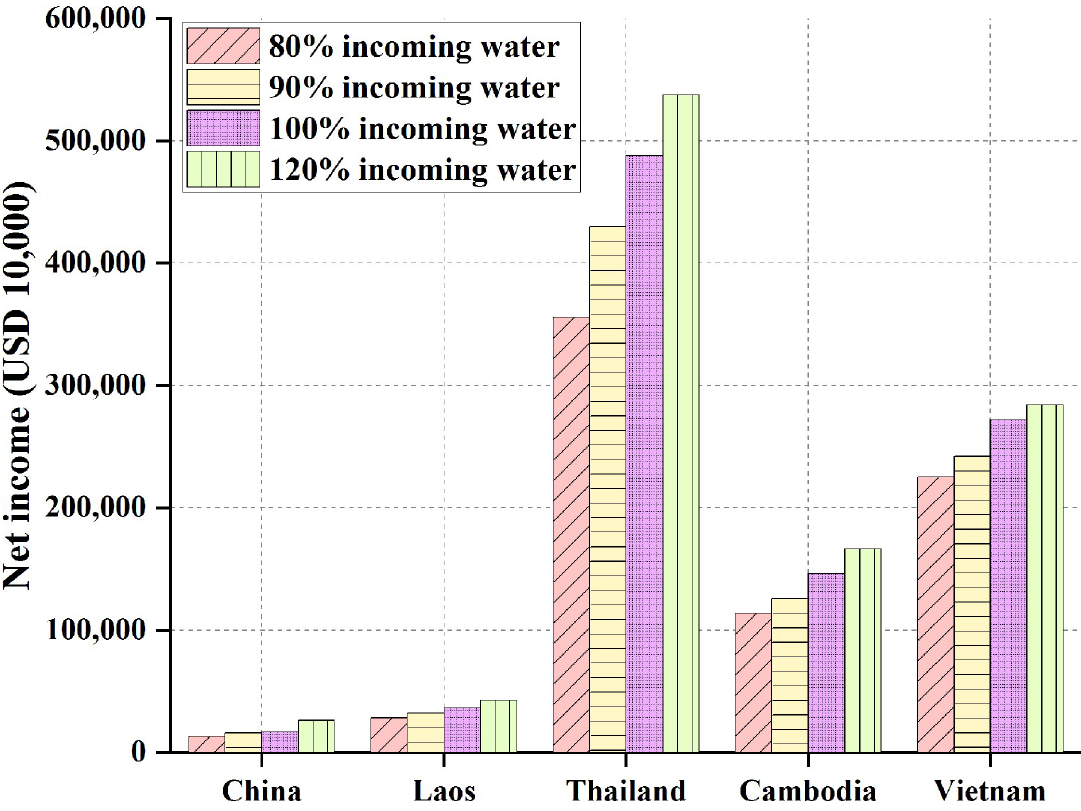
Fig 19. Benefits of each member state under the cooperation of the five